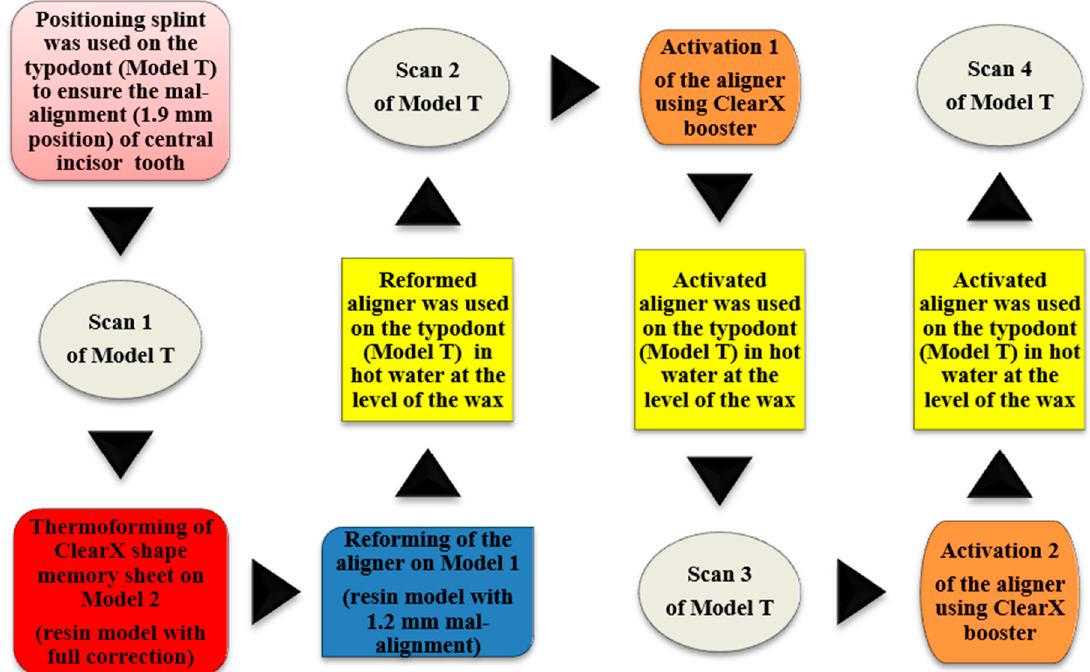
Figure 7. A schematic diagram illustrating the main steps of ClearX method.